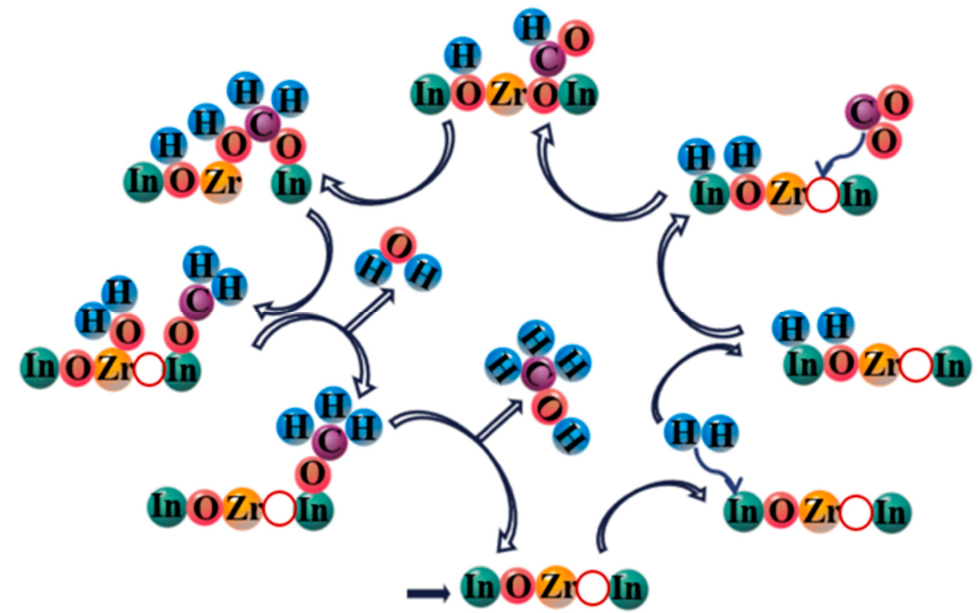
Figure 11. Catalytic mechanism diagram for CO 2 hydrogenation to methanol over In 2 O 3 /ZrO 2 catalyst prepared by precipitation-coating method. Reproduced with permission from ref. [104]. Copyright 2022 Elsevier.